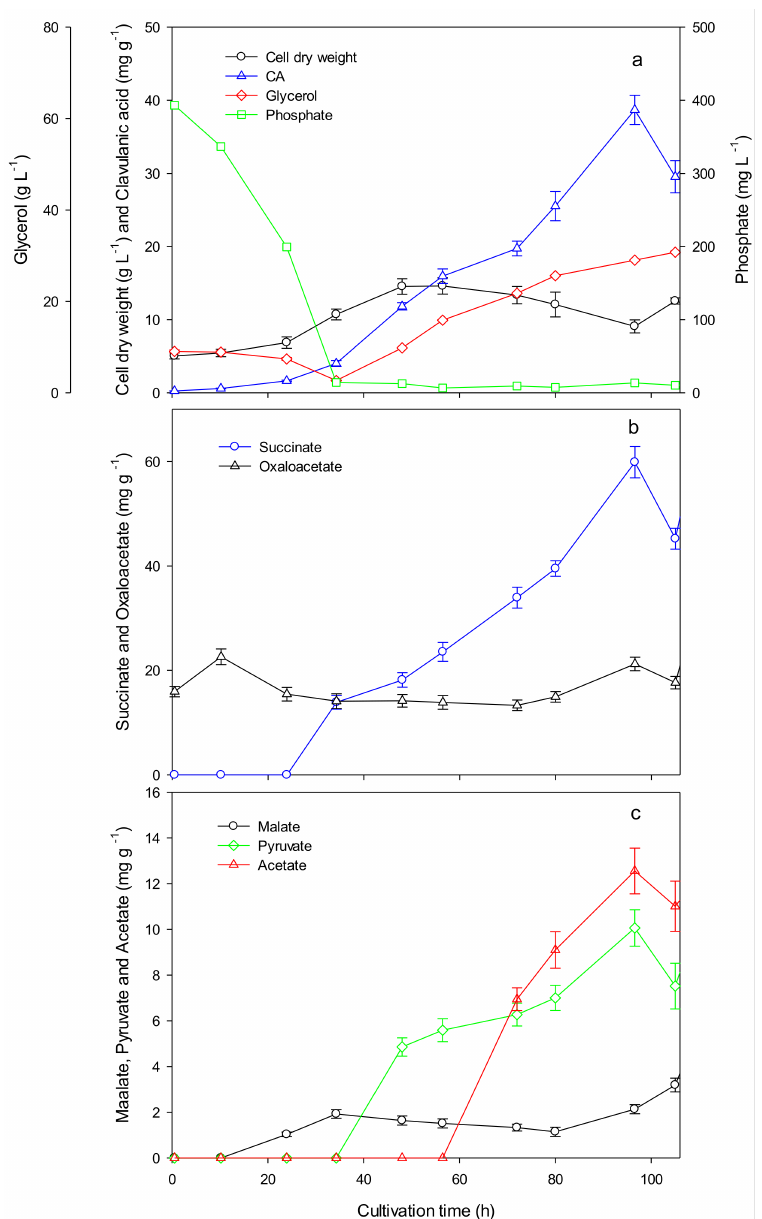
Figure 2. Fed-batch cultivation of S. clavuligerus . ( a ) Cell dry weight (circle), phosphate (square), glycerol (diamond), and clavulanic acid (triangle) as a function of cultivation time. ( b ) Succinate (circle) and oxaloacetate (triangle) as a function of cultivation time. ( c ) Malate (circle), pyruvate (diamond), and acetate (triangle) as a function of cultivation